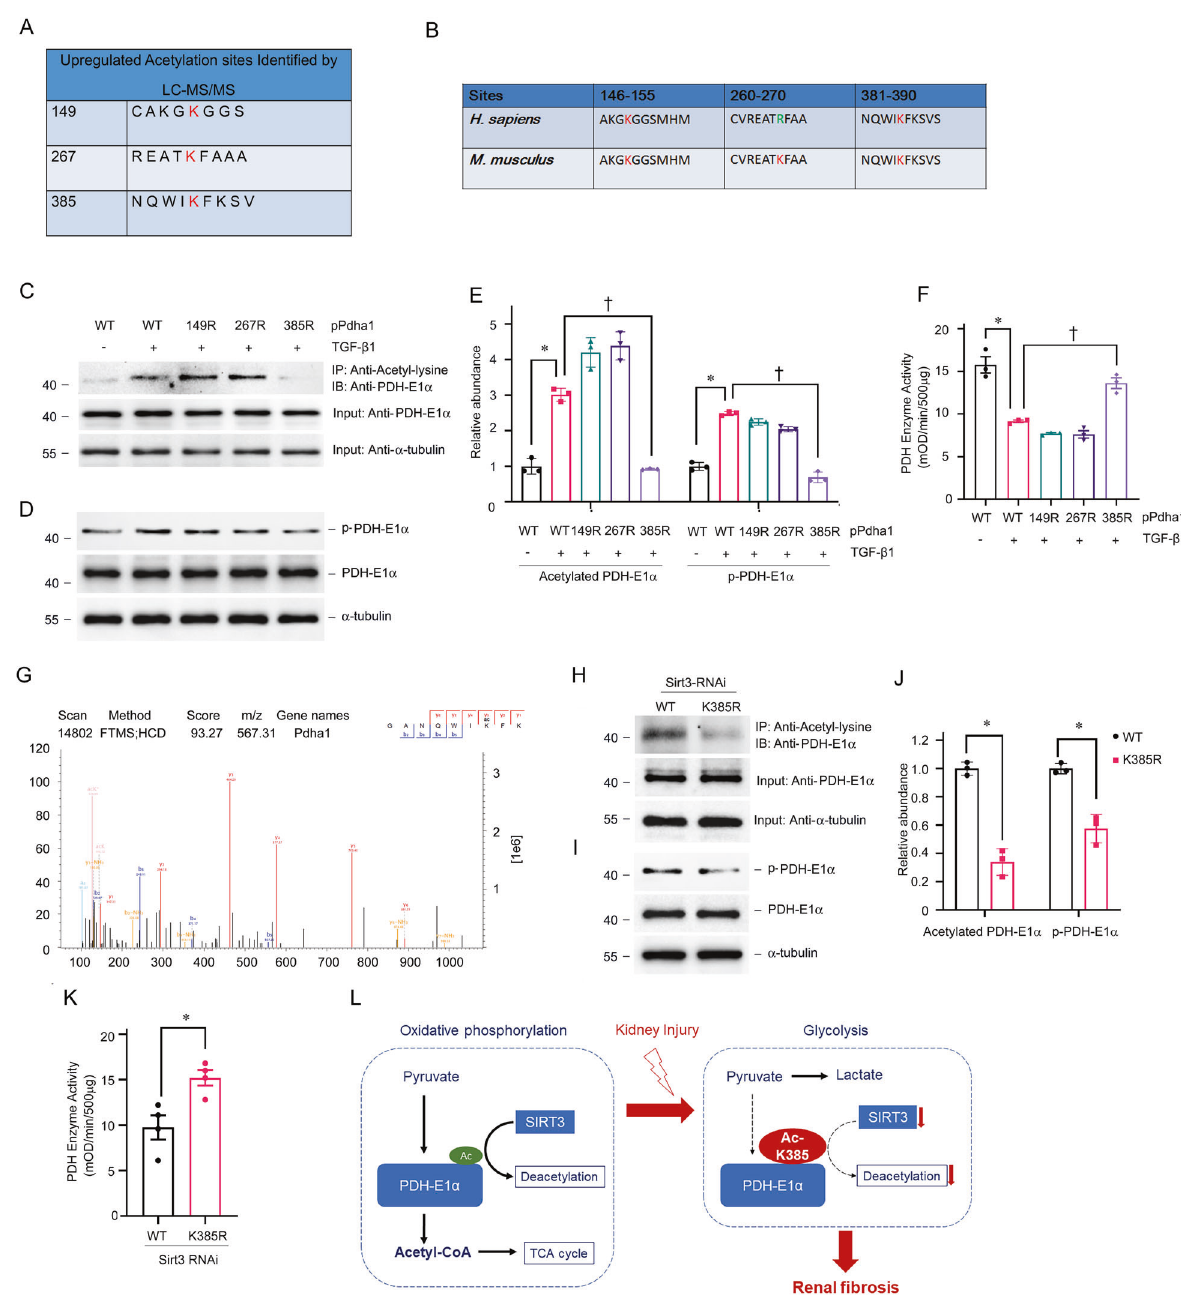
Fig. 8 Discovery of acetylated sites of PDHE1 α as a target of SIRT3 in TECs. A Summary of peptide fragments of upregulated acetylated lysine residues of PDHE1 α ; B Alignment of sequences around K149, K267, K385 of human and mouse PDHE1 α ; C – E TECs transfected with expression vectors for WT PDHE1 α , PDHE1 α single acetylation-point mutant K149R, K267R, or K385R, then stimulated with TGF- β 1. Levels of acetylated PDHE1 α ( C , E ), phosphorylated PDHE1 α ( D , E ), and PDH enzyme activity ( F ) in cell lysates. PDHE1 α served as the standard (* P < 0.05, † P < 0.05; n = 3). G Representative m / z spectra (K385) determined from mass spectrometry analyses of PDHE1 α . H – K TECs transfected with Sirt3 siRNA followed by expression vectors for WT PDHE1 α or PDHE1 α K385R. Mitochondrial lysates immunoprecipitated with anti-acetyl-lysine antibody and analyzed with anti-PDHE1 α . PDHE1 α served as the standard (* P < 0.05; n = 3) ( H , J ); Western blots of phosphorylated PDHE1 α and total PDHE1 α in TECs in Sirt3 knockdown TECs transfected with WT or PDHE1 α K385R. PDHE1 α served as the standard (* P < 0.05; n = 3) ( I , J ). K Enzyme activity of PDH in Sirt3 knockdown TECs with PDHE1 α K385R transfection vs. WT (* P < 0.05 vs. WT transfection, n = 4). L Diagram depicts the role of SIRT3 in the control of PDHE1 α deacetylation in renal fi